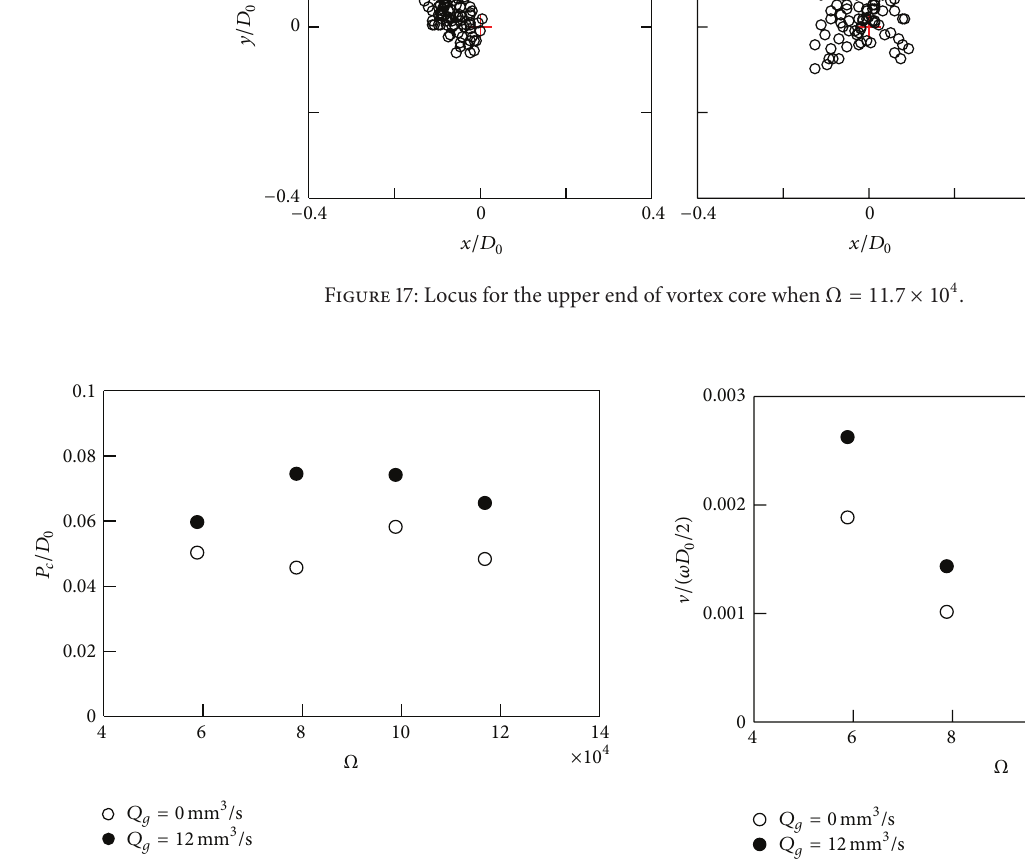
Figure18:Standarddeviationofpositionfortheupperendofvortex core.